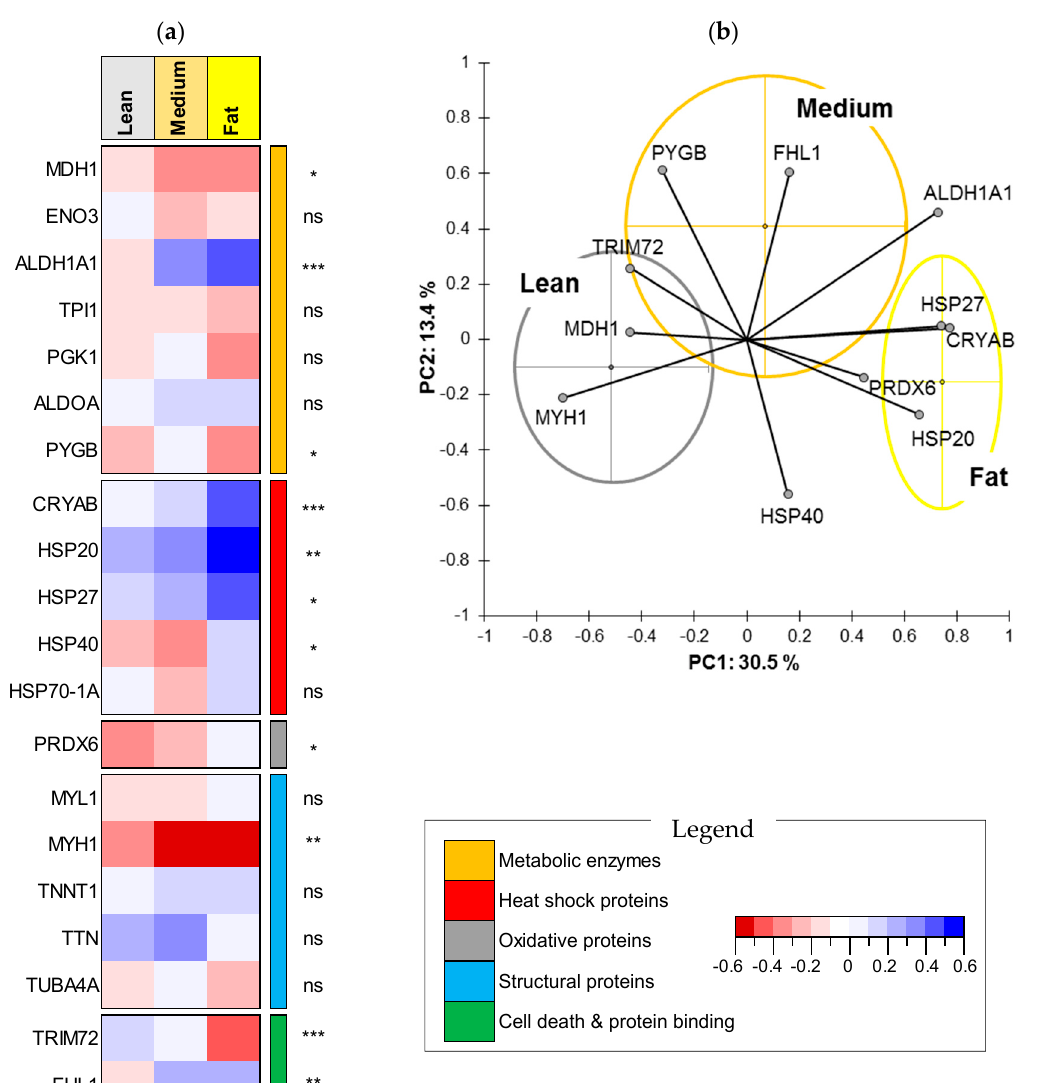
Figure 2. Protein biomarkers differing among the marbling classes (Fat ( n = 28), Medium ( n = 69) and Lean ( n = 87)). ( a ) Heatmap comparing the protein abundances among the three IMF (marbling) classes. Significance—ns: not significant; *: p < 0.05; **: p < 0.01; ***: p < 0.001. The proteins are given